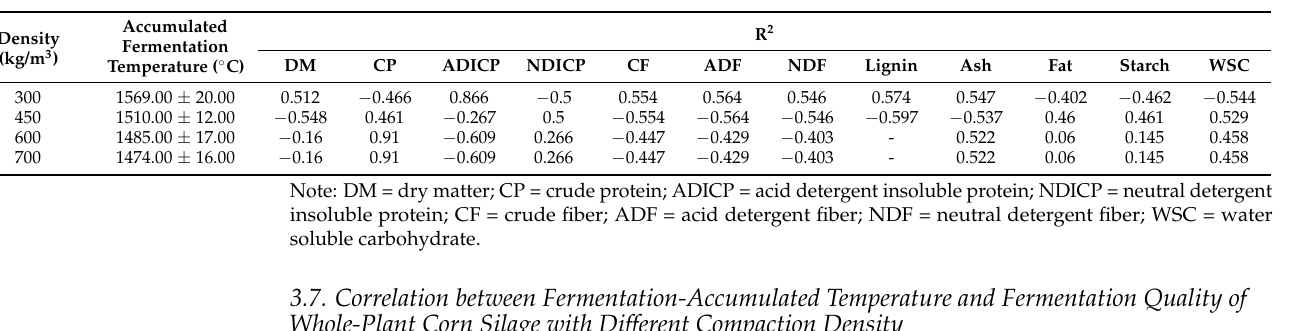
Table 5. Correlation between accumulated fermentation temperature and nutritional quality of whole-plant corn silage.